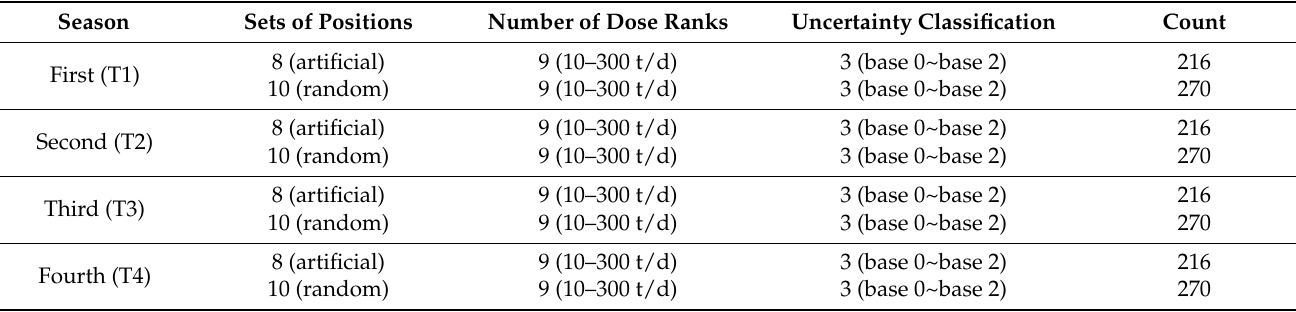
Table 2. Permutations and combinations of design parameters.